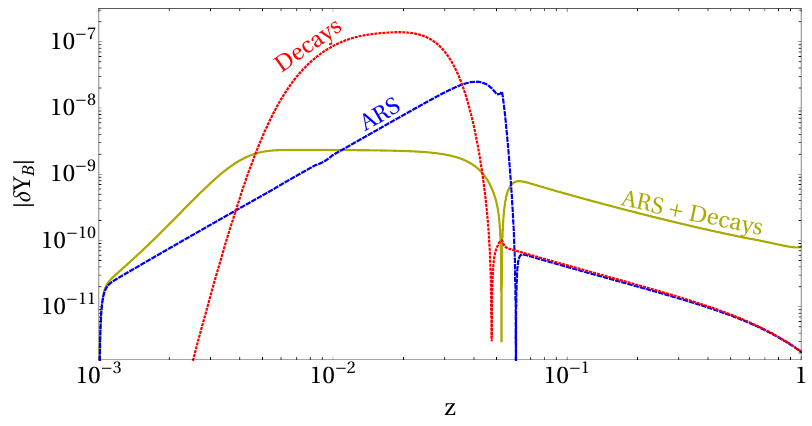
Figure 8. Time evolution of j (cid:14)Y B j for the cases of (cid:6) decays (red dotted) and ARS (blue dashed) shown together with the general case when the both production mechanisms are included (yellow solid). We take (cid:24) = 3 and m N = 400 GeV. It is evident that the combination of both production 2 mechanisms su(cid:14)ces to account for BAU, in contrast with the individual